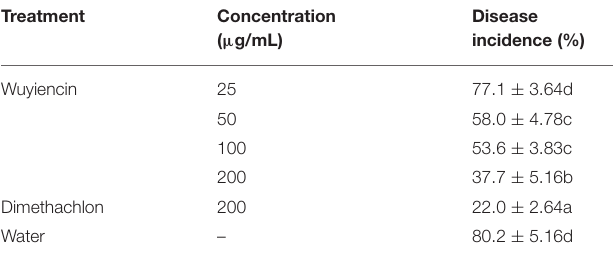
TABLE 5 | Effects of wuyiencin on disease incidence of inoculated S. sclerotiorum .